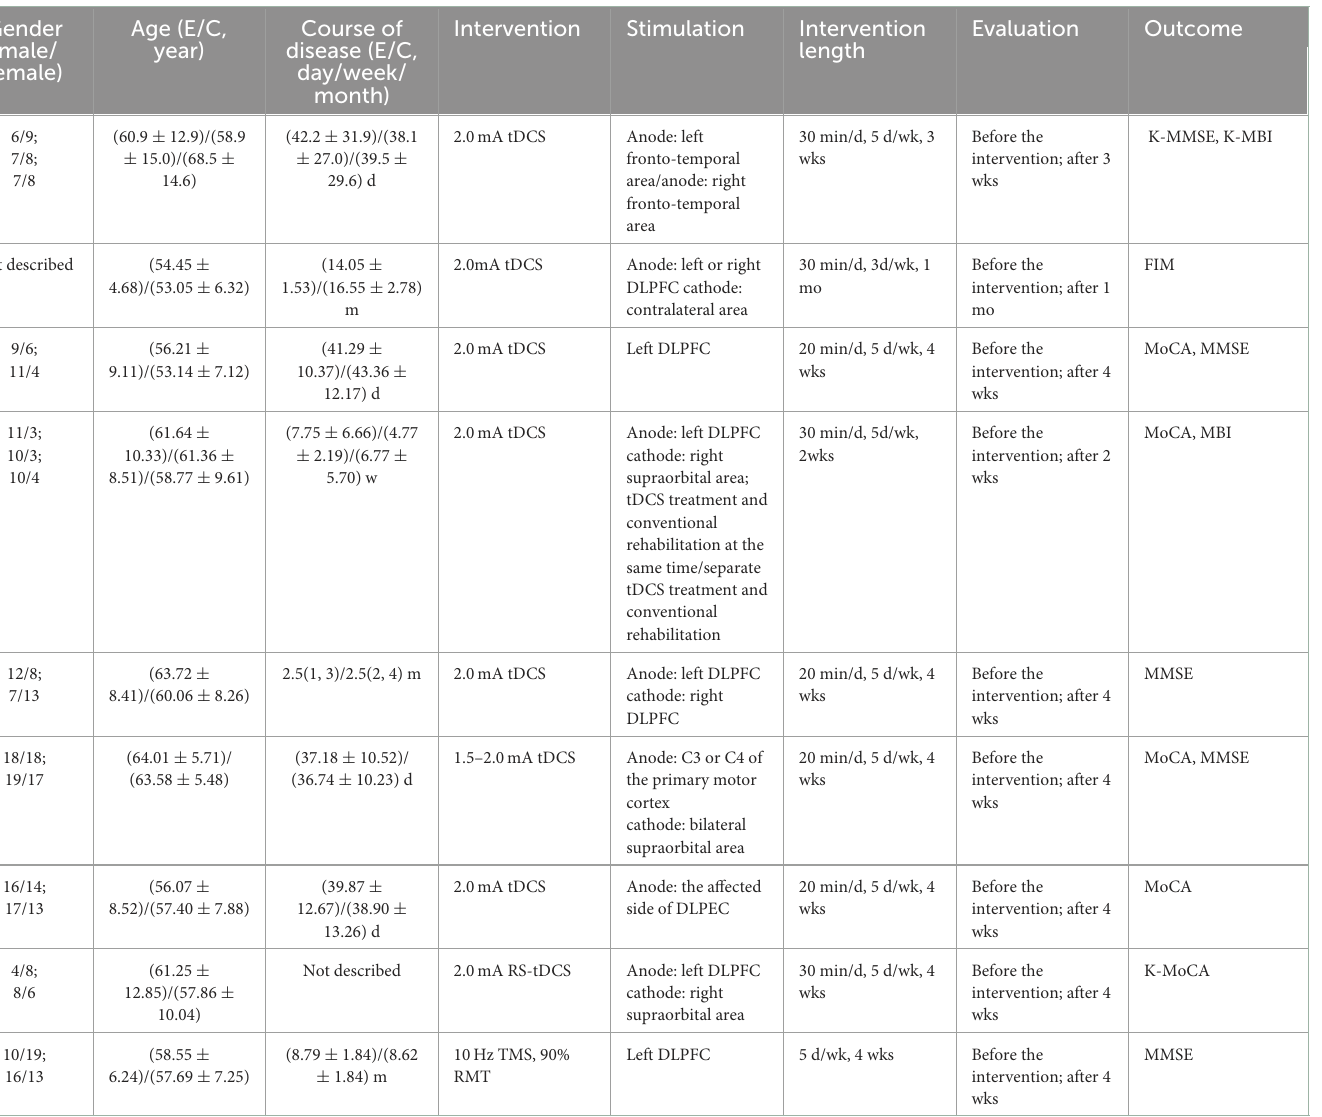
TABLE 1 Characteristics of included